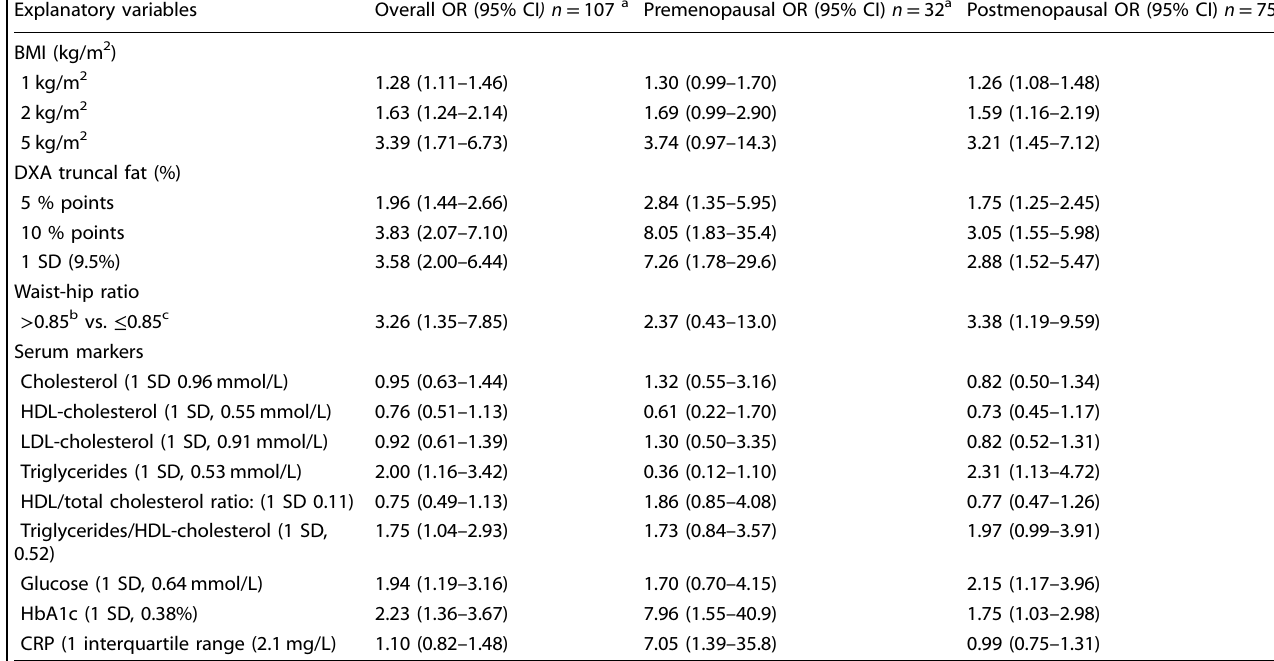
Table 2. Multivariable adjusted odds ratio (OR) for presence of CLS in fat tissue surrounding tumor according to anthropometric and metabolic measures, overall and by menopausal status Explanatory